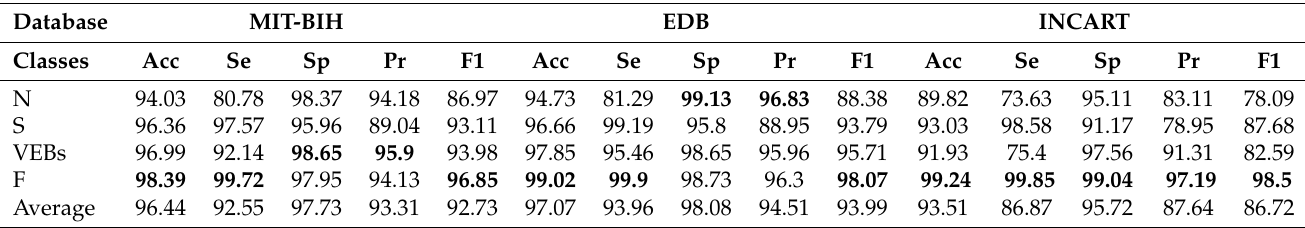
Table 7. The performance of the MPA-kNN classifier on all the databases’ classes.